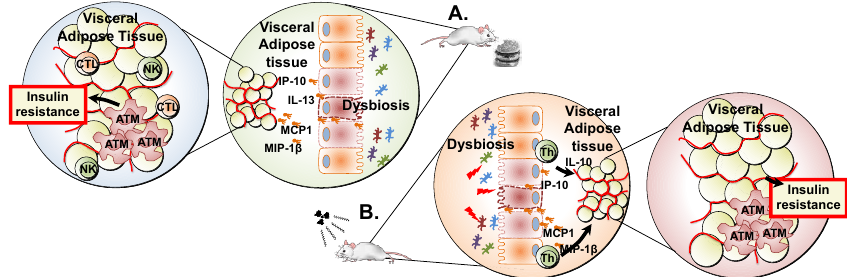
Figure 6. Effect of high-fat diet and irradiation on gut microbiota, immune profile, and metabolic functions. ( A ). High-fat diet leads to disturbances in the gut microbiota. Disturbance in gut micro- biota could lead to intestinal inflammation and impaired gut permeability, resulting in systemic bacterial translocation. This in turn could be linked to systemic immune activation, remodelling of the systemic profile of cytokines, and increased infiltration of immune cells in the visceral adipose tissue. This change in the immune profile in adipose tissue could ultimately affect adipogenesis and result in insulin resistance [14]. ( B ). Irradiation leads to limited changes in the gut microbiota, but to a more dramatic remodelling of the systemic profile of cytokines and immune cells, potentially through direct immune activation [8]. The associated increased infiltration of proinflammatory mac- rophages to the visceral adipose tissue could ultimately impair adipogenesis and result in insulin resistance. CTL — cytotoxic T lymphocytes, NK — natural killer cells, ATM — adipose tissue macro- phages, IP-10 — Interferon gamma-induced protein-10, IL-13 — Interleukin-13, MCP1 — Monocyte Chemoattractant Protein-1, MIP- 1β— Macrophage inflammatory protein-1 beta, IL-10 — interleukin 10, Th — T helper cells.